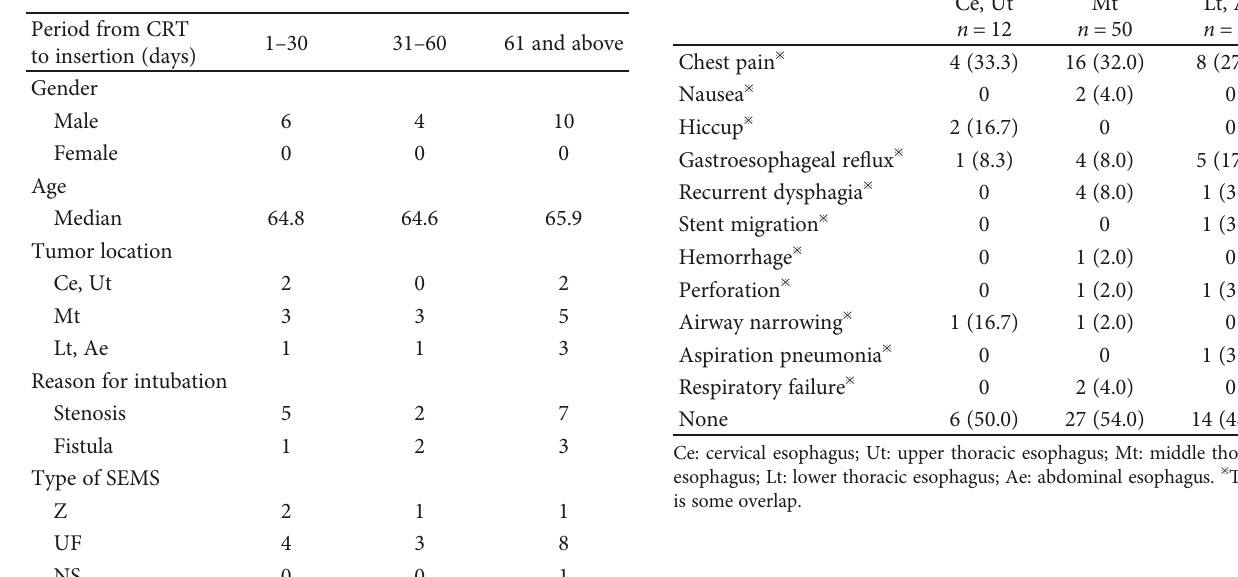
Table 5: Relationships of the chest pain and the period from chemoradiotherapy (60Gy) completion to stent insertion ( n = 20 patients).